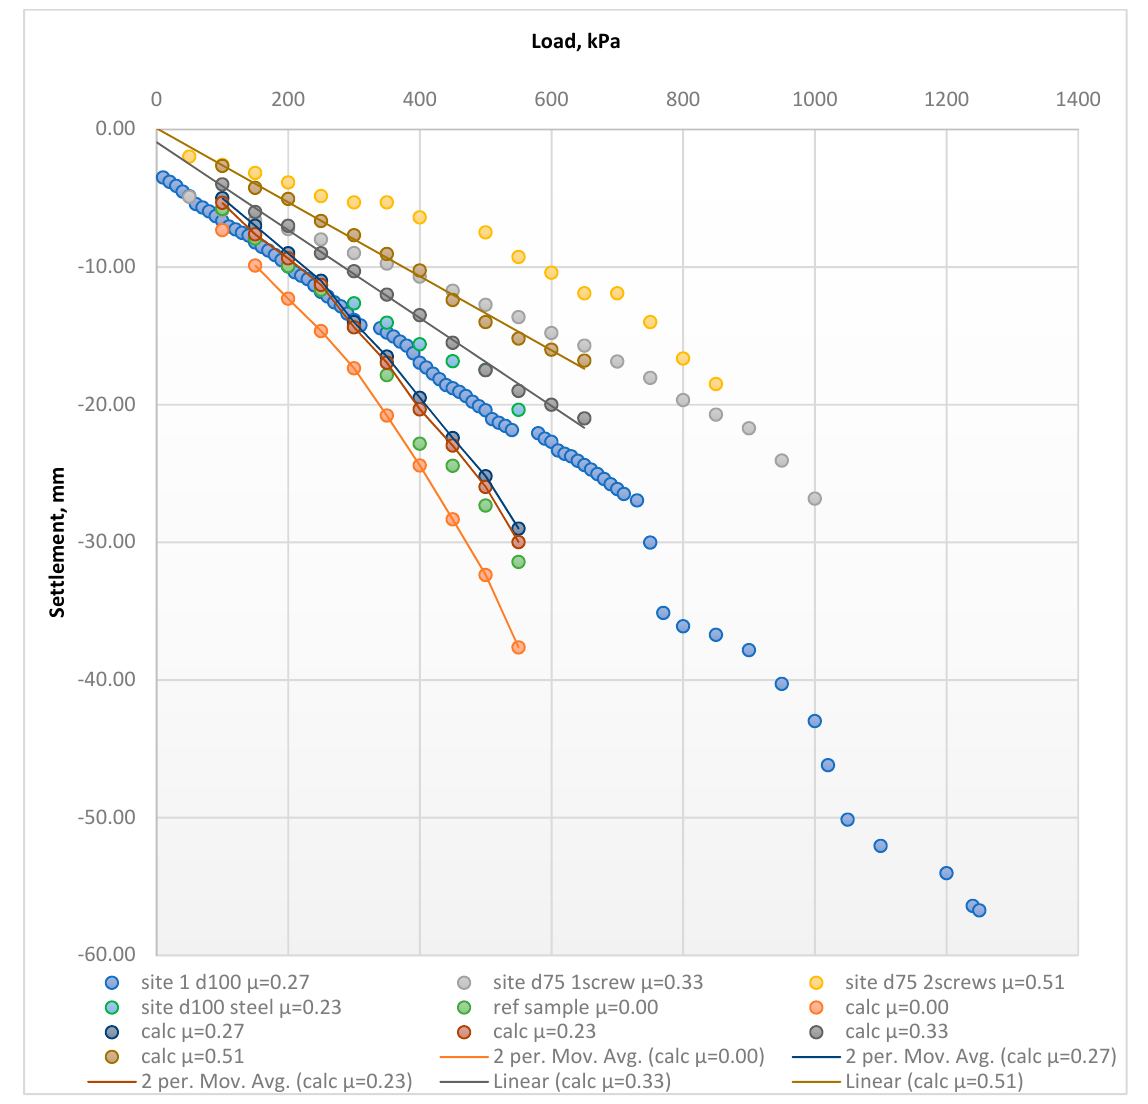
Figure 10. The load − settlement curve of each of the tested in situ samples, as compared with the theoretical calculation results.